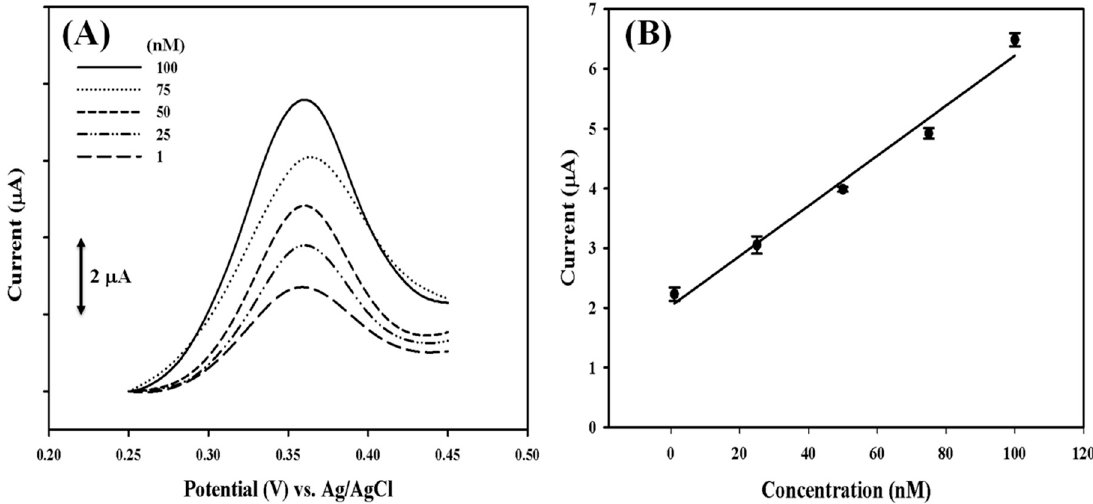
Figure 6. ( A ) DPV profiles of ssDNA-AuNP-PEDOT/PEDOT:PSS/Pt electrode in response to different concentrations of complementary target DNA in the presence of 10 μ M of oxidized form NAD + . ( B ) The linear correlation between the peak current and the concentration of target DNA.